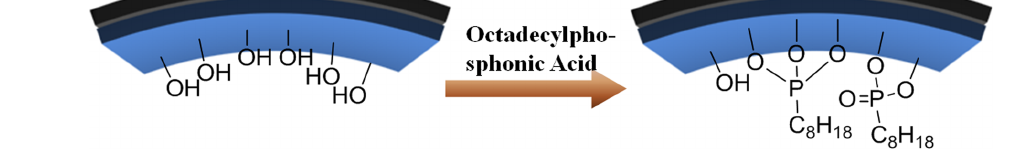
Figure 5: Selective modification of the inner surface by octadecylphosphonic acid proposed by Lvov et al. [19]